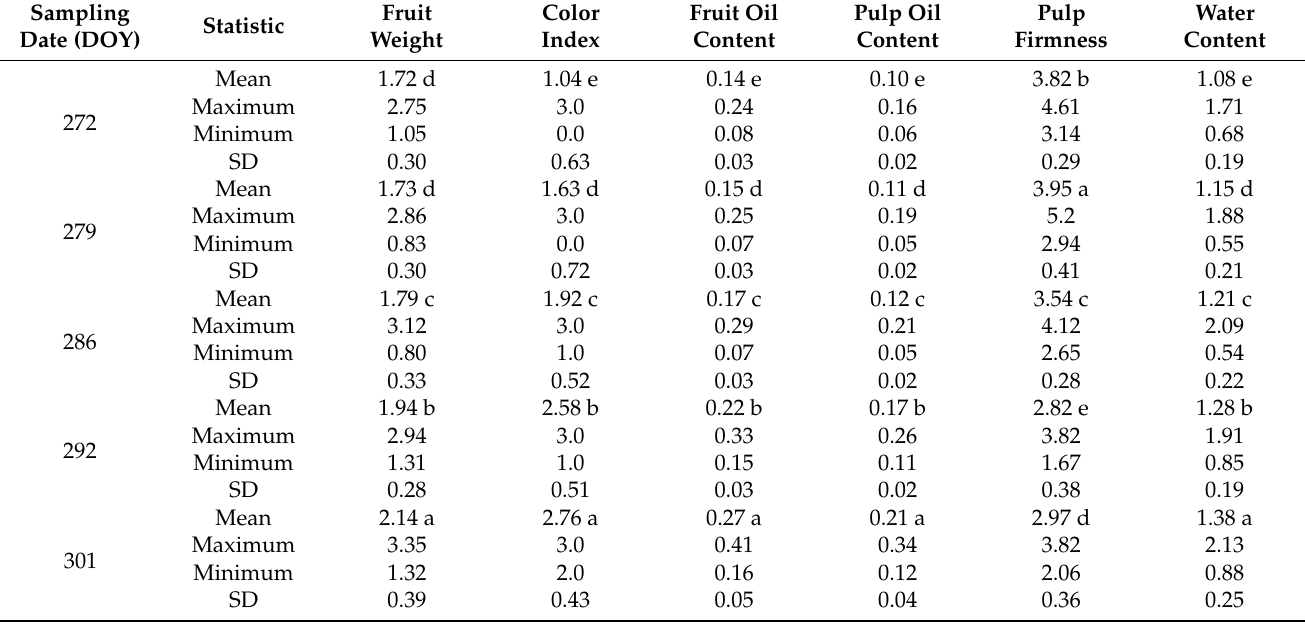
Table 1. Minimum, maximum, mean and standard deviation (SD) of the different measured parame- ters of olive samples at different degrees of